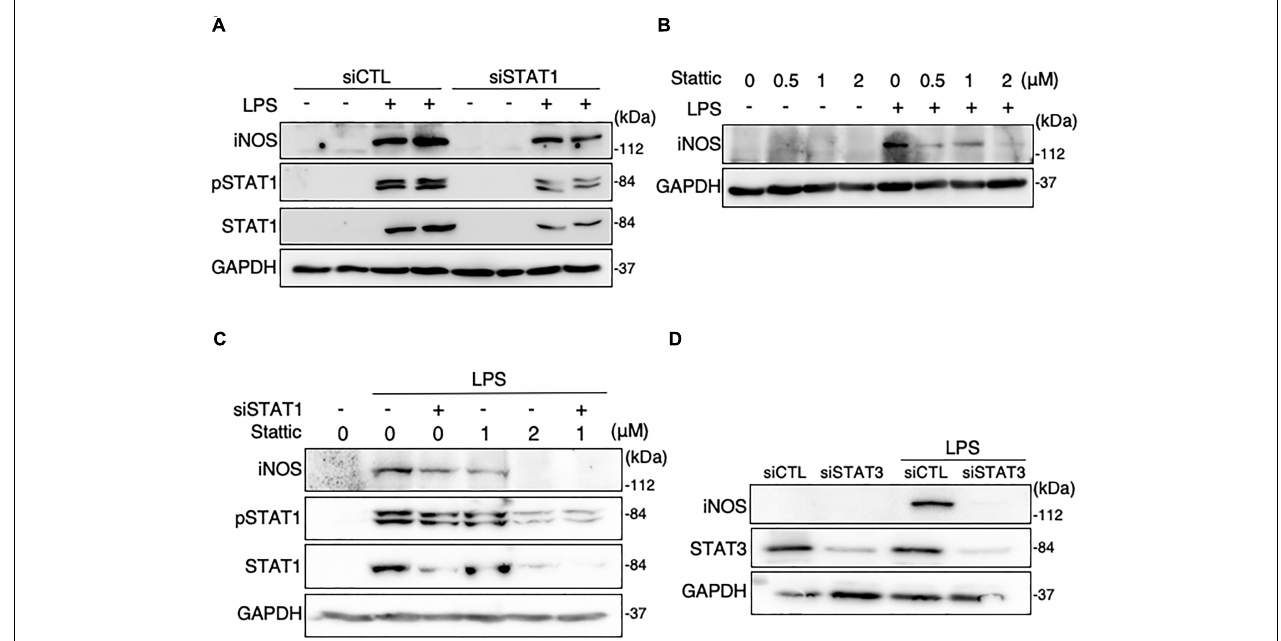
FIGURE 2 | Effects of STAT1 siRNA transfection and stattic on protein expression levels of iNOS and total and phosphorylation levels of STAT1 in LPS-stimulated MG6 cells. (A) iNOS, phospho-STAT1 at Tyr-701, and total STAT1 before and 15 h after 100 ng/ml LPS application in the presence of or STAT1 siRNAs (siSTAT1) or the negative control siRNAs (siCTL). (B) Concentration-dependent effect of stattic (0.5–2 µ M) on iNOS expression before and 15 h after 100 ng/ml LPS application. (C) Effects of siSTAT1 alone, stattic (2 µ M) alone, and combination of siSTAT1 and stattic (1 µ M) on iNOS, phosphorylated STAT1, and total STAT1 before and 15 h after 100 ng/ml LPS application. (D) Effect of STAT3 siRNAs (siSTAT3) on iNOS and STAT3 expression before and 15 h after 100 ng/ml LPS application. GAPDH served as loading control. Shown are representative Western blots from three independent experiments in which the same results were obtained.